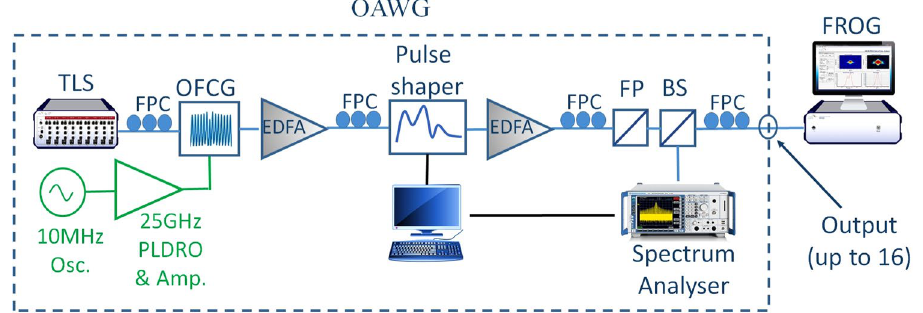
Figure 12. Schematic of the programmable OAWG. TLS: tunable laser source, OFCG: optical frequency comb generator, FPC: fiber polarization controller, FP: fiber polarizer, BS: beam